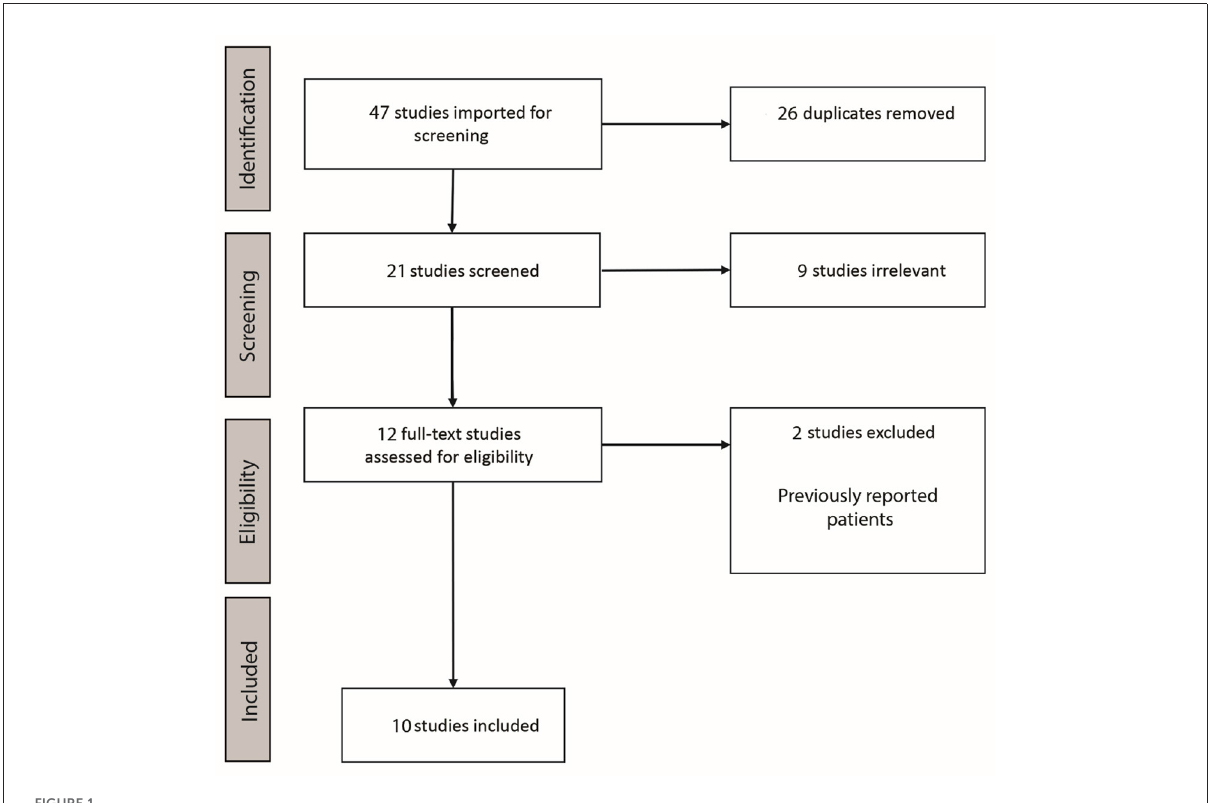
FIGURE1 Flowchart of the systematic review for insular